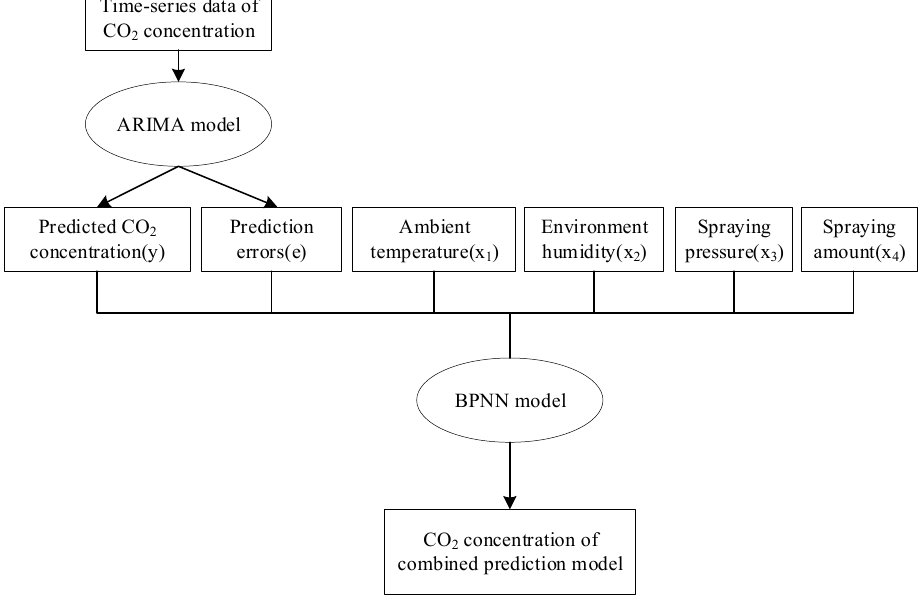
Figure 4. Flowchart of the ARIMA-BPNN hybrid model.